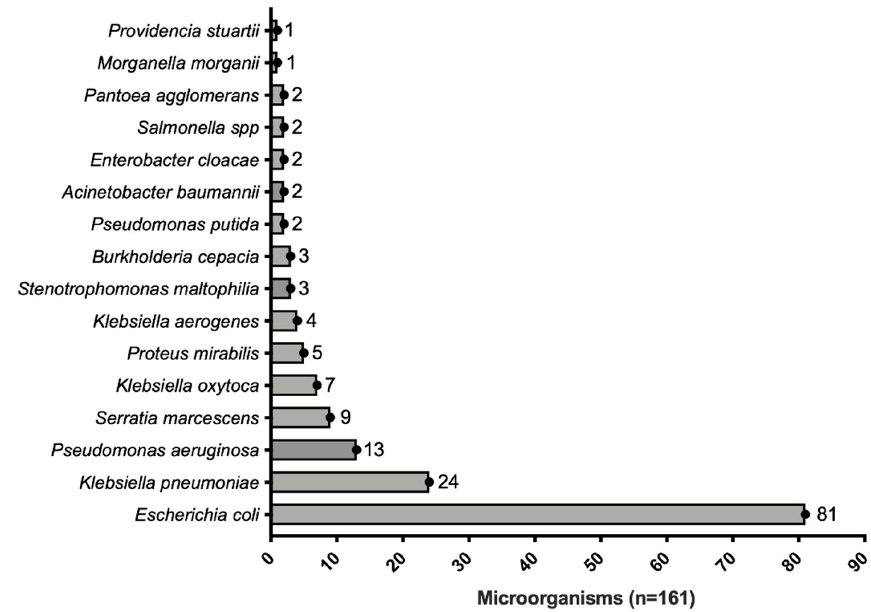
Figure 2. Distribution of microorganisms retrieved from patients with bacteremia. Table 2. Distribution of resistance profiles and concordance between the conventional identification method and antibiogram and the method proposed by HB&L.